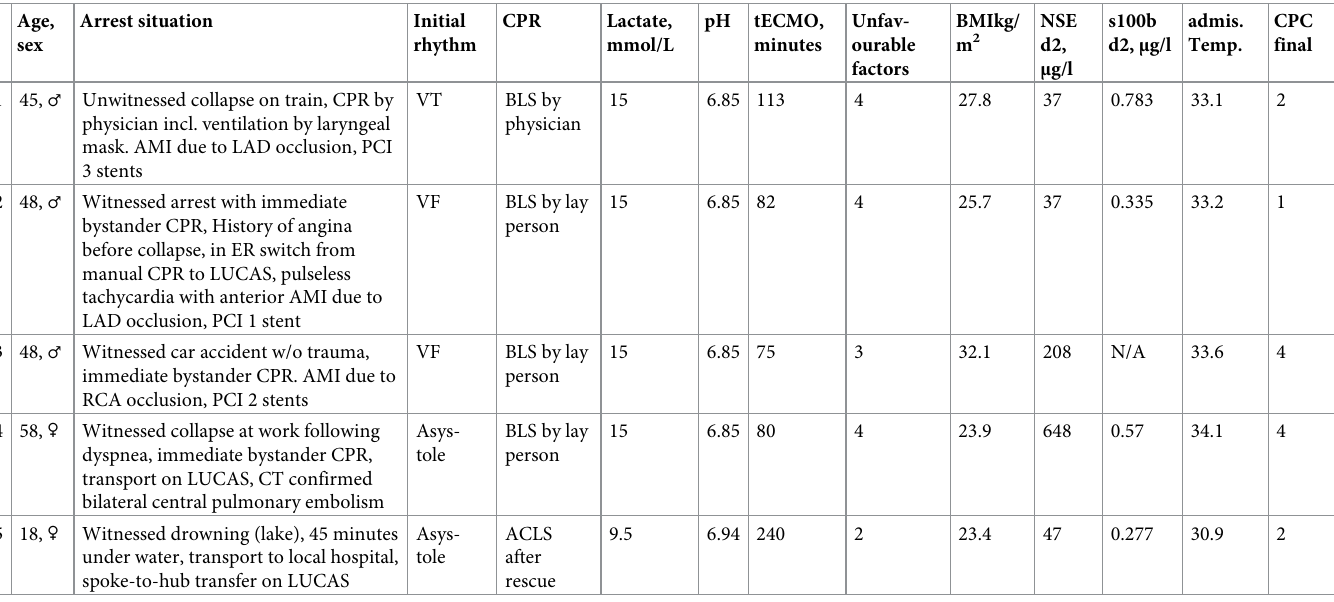
Table 3. Individual characteristics of